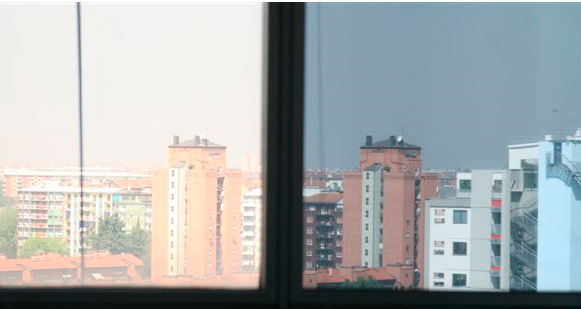
Figure 11. View of the external environment without applied film (left window) and with applied film (right window) [5].